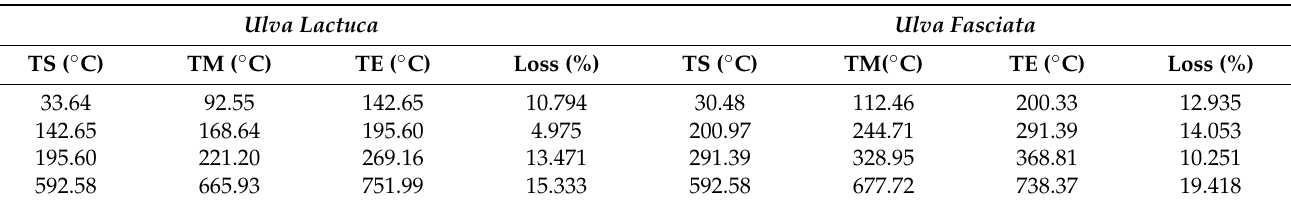
Table 2. TGA analysis of the extracted polysaccharides from U. fasciata and U. lactuca . Ulva Lactuca Ulva